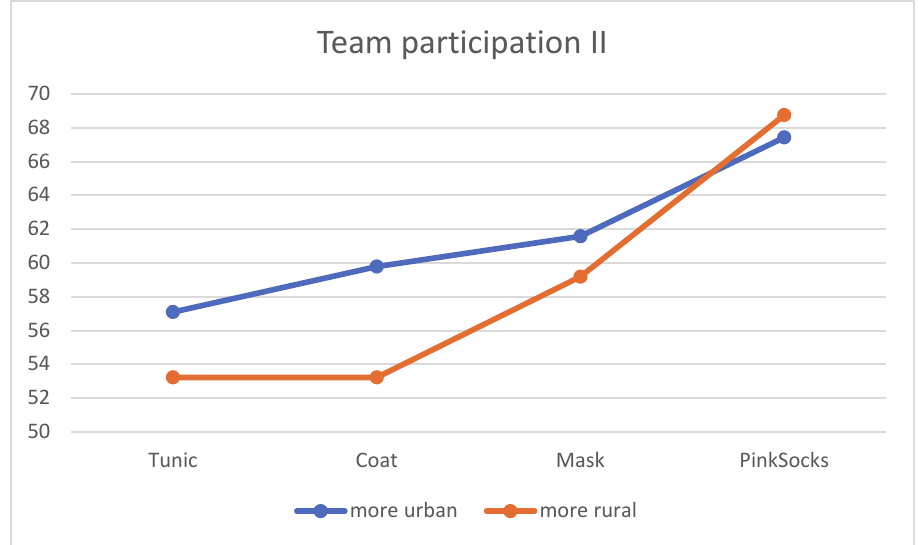
Figure 8. Mean rating of the four photos for team participation by the two subgroups according to place of residence ( n = 906).